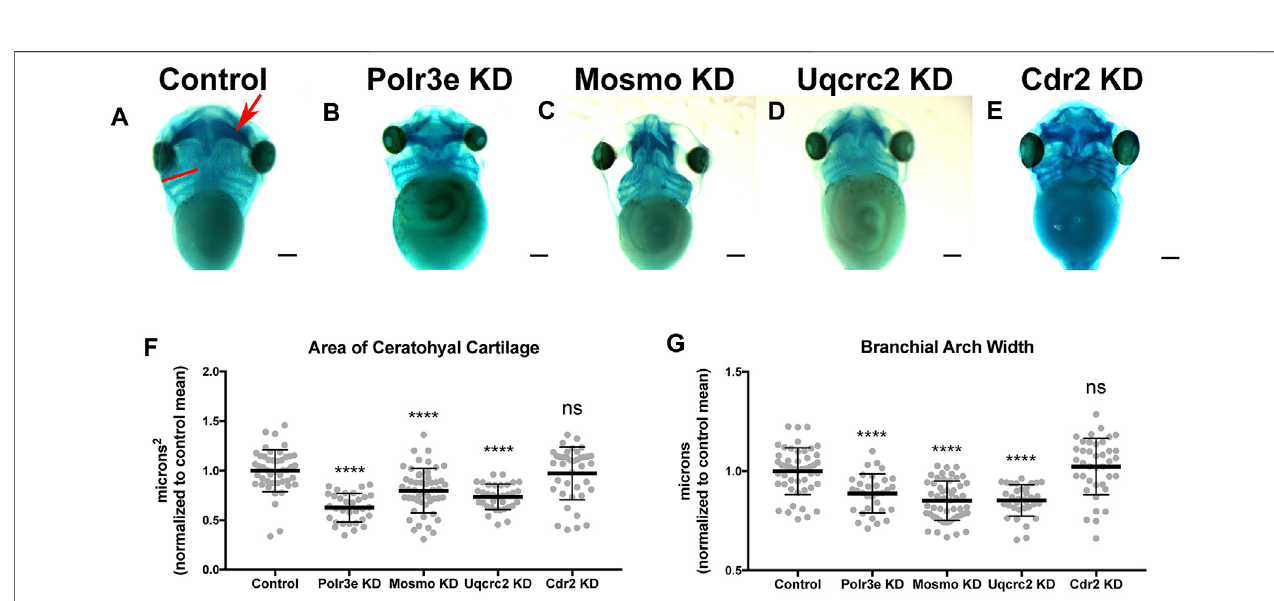
FIGURE2| KnockdownofPolr3e,Mosmo,andUqcrc2impactcartilagemorphology. (A – E) Ventralviewofstage42embryosfollowingsingle16p12.1-associated geneKD,stainedwithAlcian bluetolabelcartilage elements. Anteriorofembryoisatthetop. Inthecontrol,theredarrow points toceratohyalcartilage,while theredbar spans the fi rst branchial arch. (F – G) Measurements of the average ceratohyal area and width of the fi rst branchial arch. The data was normalized to the control MO condition.PartialdepletionofPolr3e,Mosmo,andUqcrc2signi fi cantlyreducedthesizeofbothofthesecartilageelementscomparedtocontrols,whiledepletionof Cdr2 had no effect on cartilage size. Signi fi cance determined using a student ’ s unpaired t -test. (Embryos quanti fi ed: Control = 48, Polr3e KD = 32, Mosmo KD = 51, Uqcrc2 KD = 34, Cdr2 KD = 39). **** p < 0.0001, *** p < 0.001, ** p < 0.01, * p < 0.05, n.s., not signi fi cant. Scalebar = 300 μ m.